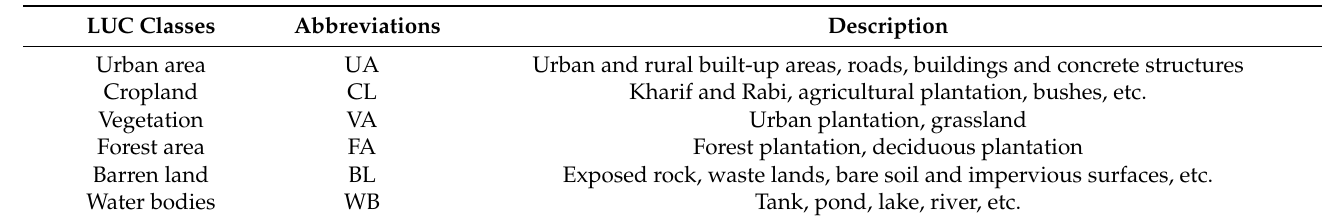
Table 2. Land use and land cover types in the study area.